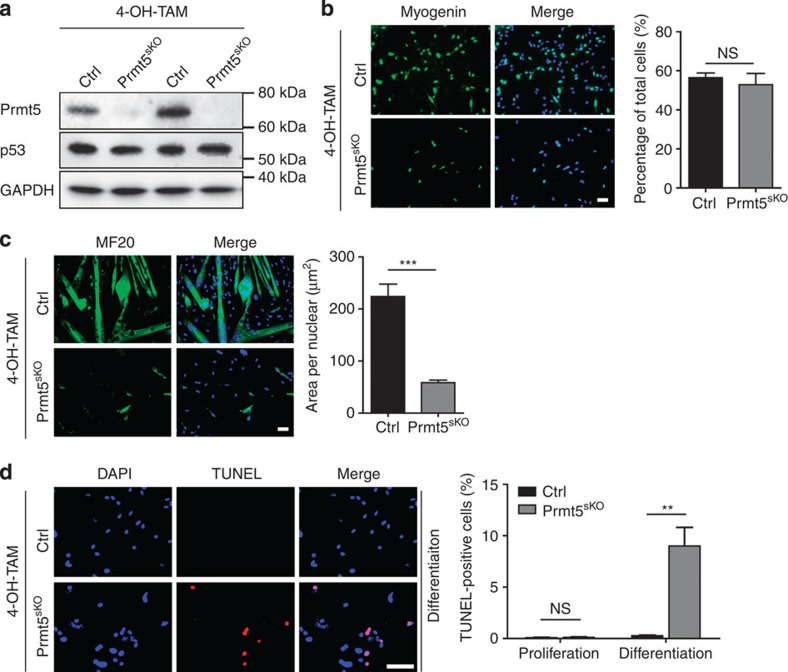
Prmt5 is required for survival of MuSC upon differentiation.(a) Western blot analysis of Prmt5 and p53 protein levels in isolated MuSC of Prmt5sKO and control littermates after in vitro 4-OH TAM treatment (n=2). (b,c) Immunofluorescence staining for MyoG (b) and MF20 (c) of control and Prmt5sKO MuSC, which were in vitro amplified and subsequently treated with 4-OH-TAM, 2 days after induction of differentiation. Scale bars, 20 μm. The percentage of MyoG+ and MF20+ cells is shown on the right. Error bars represent s.d.'s of the mean. (t-test: ***P<0.001; NS, P>0.05, n=3). (d) TUNEL assays of FACS-sorted control and Prmt5-deficient MuSC in differentiation medium (n=3, each). Scale bar, 20 μm. Quantifications are shown on the right. Error bars represent s.d.'s of the mean (t-test: **P<0.01; NS, P>0.05). Control (Ctrl): Pax7CreERT2+/−/Prmt5+/loxP; Prm5sKO: Pax7CreERT2+/−/Prmt5loxP/loxP. NS, not significant.